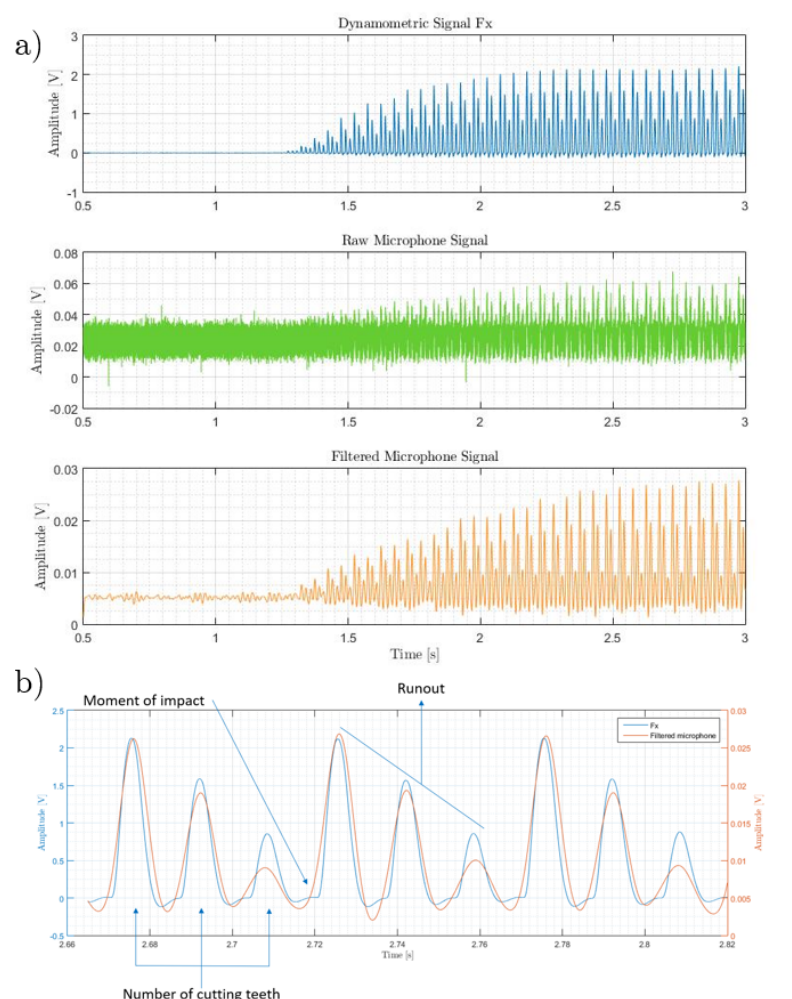
Figure 8. Experimental signals under analysis. ( a ) Cutting force signal (top), raw AE signal (middle), and filtered AE signal (bottom). ( b ) Zoomed section of the cutting force and filtered AE signals within the zone of uniform cut.